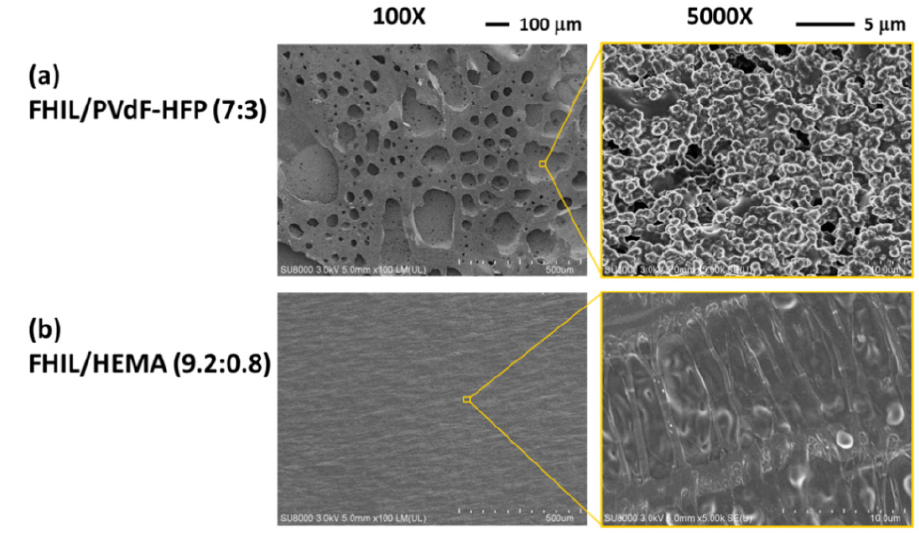
Figure 4. SEM images of ( a ) EMPyr(FH) 1.7 F/PVdF-HFP (7:3) composite membrane and